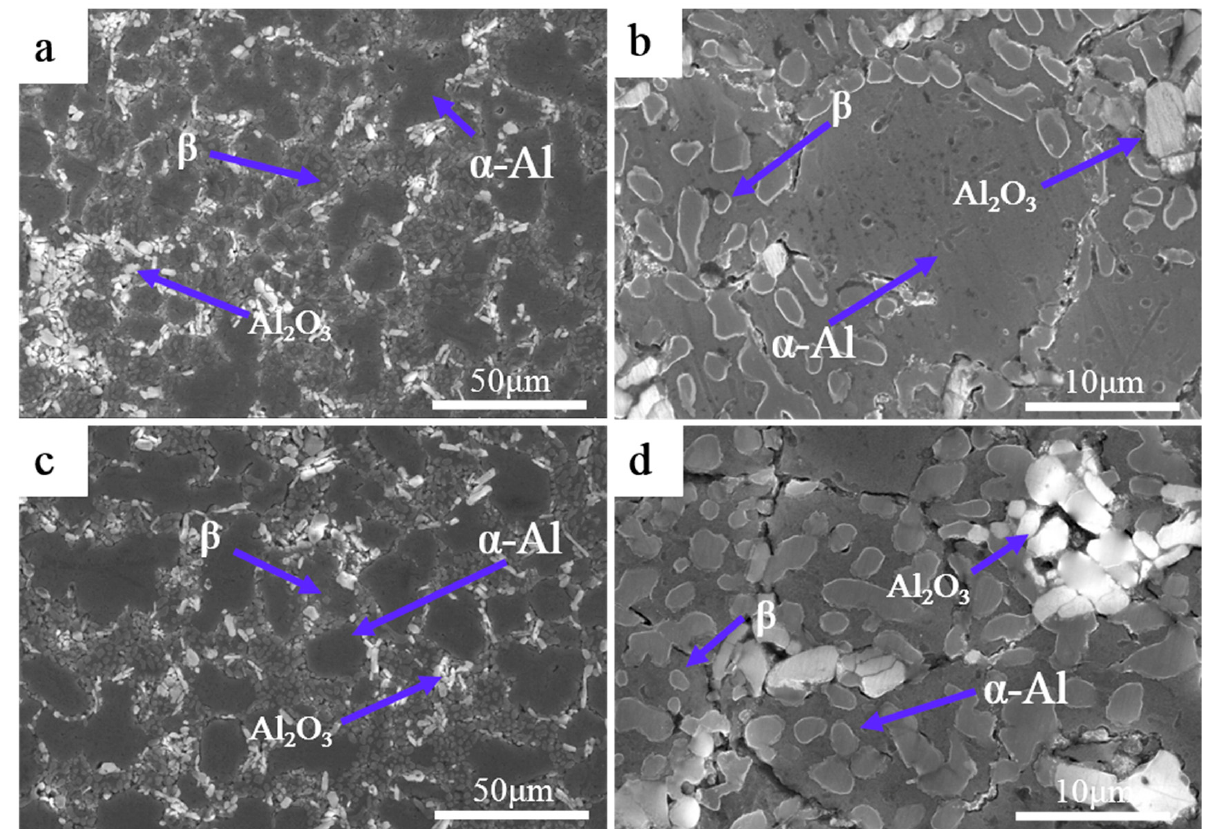
Figure 3. High-pressure solidified Al 2 O 3 /Al-20Si composite morphology ( a , b ) 3 GPa, ( c , d ) 4 GPa.